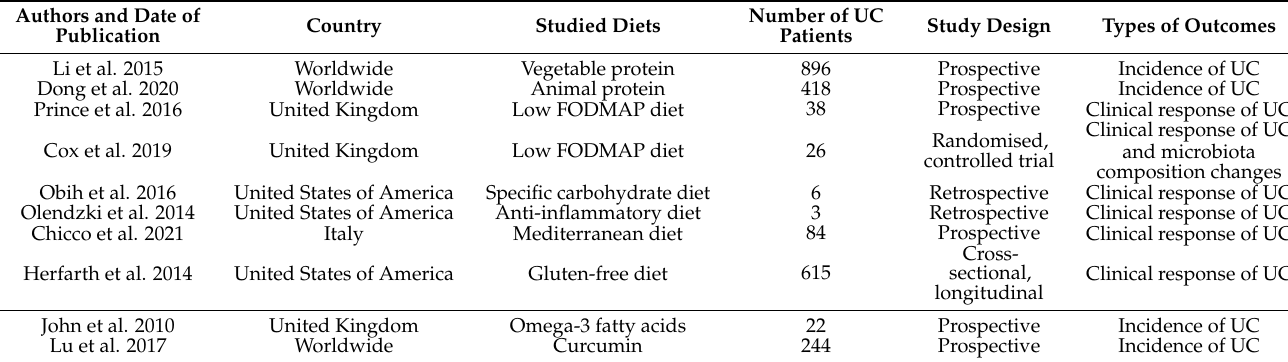
Table 1. Summary of published dietary studies regarding incidence and treatment of ulcerative